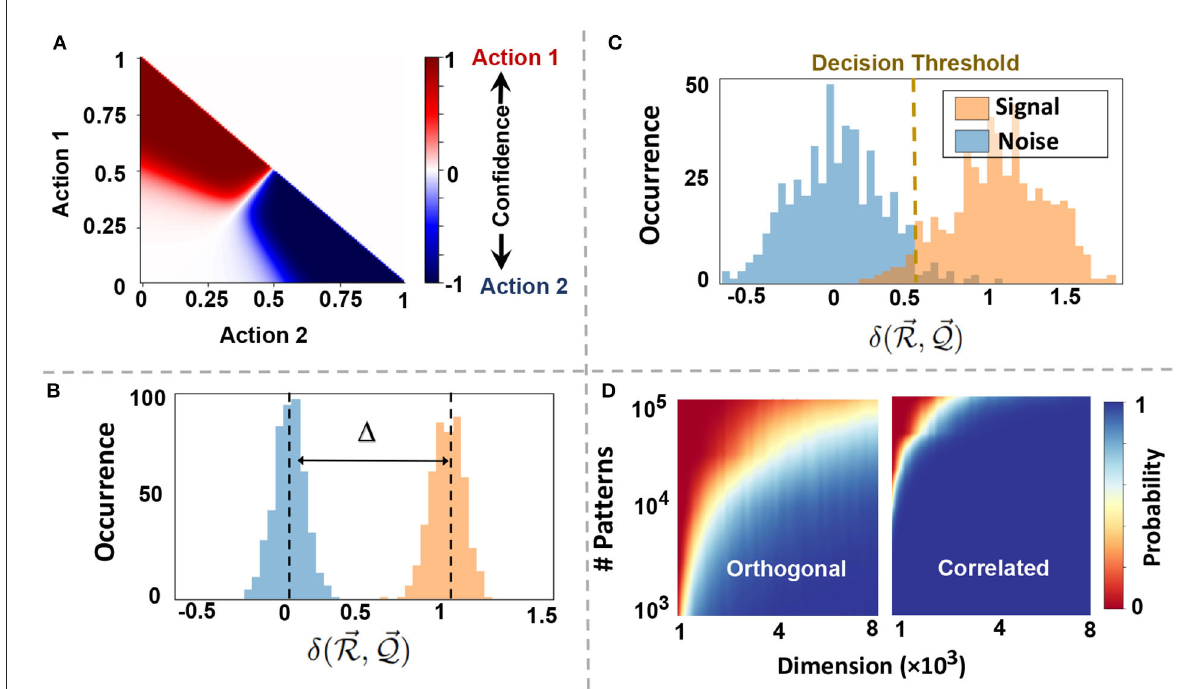
FIGURE4 Information association and memorization: (A) perception-action association. Depending on the confidence of a query to the memorized perceptions measured by similarity, EventHD picks one of the actions with the highest confidence. (B,C) Distribution of signal and noise signal when referencing hypervector with D = 4 k is storing N = 10 3 and N = 10 4 orthogonal patterns. When the number of patterns stored is low, like (B) , the distribution of the similarity of signal and that of noise are separable, implying perfect signal detection quality; when the number of patterns is high, the distributions overlap, and signal detection has less accuracy. (D) The capacity of reference hypervector with different dimensions storing orthogonal and correlated hypervectors. Compared to orthogonal hypervectors, correlated hypervectors require less capacity to store, resulting in higher detection probability (bluer) given fixed hyperdimension and